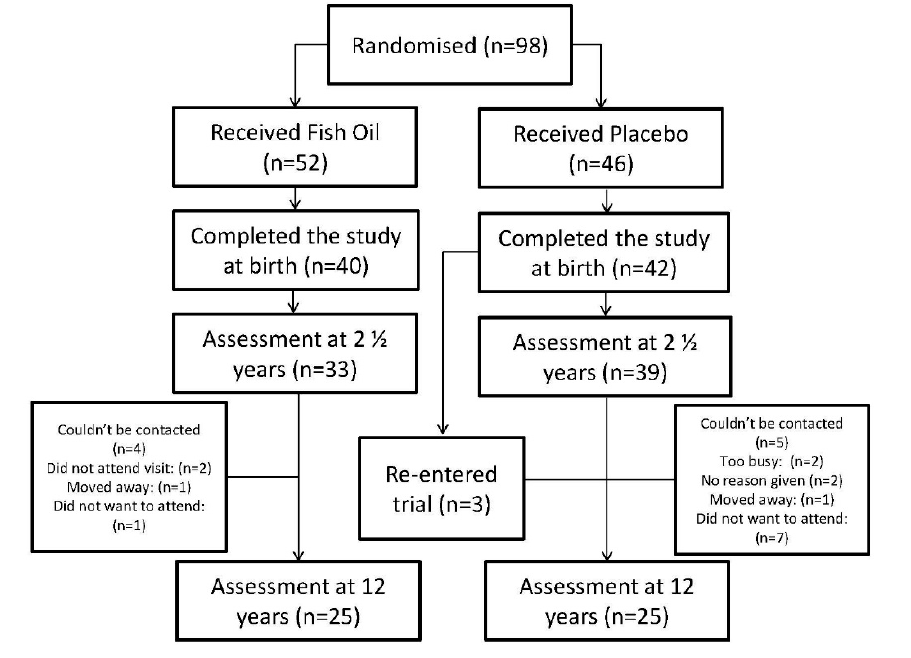
Figure 1. Trial design and participant